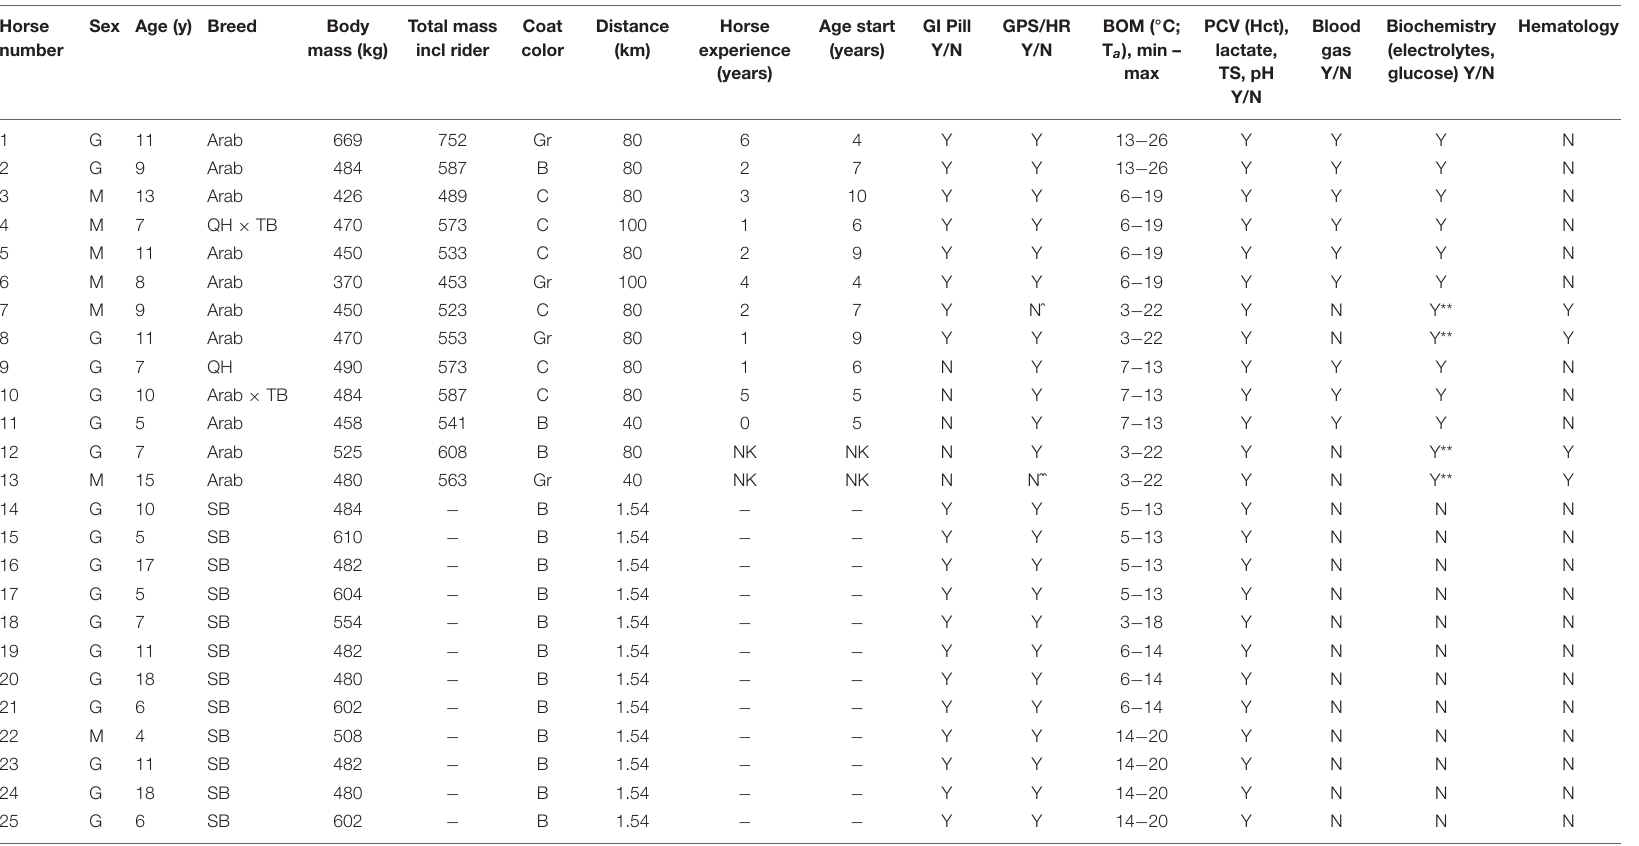
Horse 1–13: 13 endurance horses: G (n = 7), M (n = 6). Arab include part Arabian horses, QH, quarterhorse; TB, thoroughbred, endurance exercise; Horse 14–25 : 12 untrained trotters, all Standardbred (SB): G (n = 12), fast trot exercise; G, gelding; M, mare. Gr, gray; C, chestnut; B, bay; The riders’ and horses’ performance history includes: age start, indicates age (years) when horse started competing; horse experience, indicates number of years in competition (40 km or more); GI pill, gastrointestinal pill; GPS, global positioning system; HR, heartrate monitor (Polar); BOM (2020); Bureau of Meteorology, local stations closest to location of exercise at varying km distance from the actual event in total 4 endurance locations and 1 trotter racetrack, distance ranged from 5.3 to 53 km; BOM stations were: Roseworthy 27.9 km distance from ride at Sandy Creek; Rosedale station 5.3 km from ride at Tarlee; Meningie station 53 km from ride at Coorong; Nuriootpa station 28.8 km from ride at Sedan; Roseworthy station at 2.2 km from trotter racetrack; N, no; Y, yes; NK, not known; ∧ indicates HR only; ∧∧ indicates second 40 km only; blood gas analysis included pH, pCO 2 , pO 2 , HCO 3 − , base excess and lactate levels; **indicates biochemistry by VETSCAN (utilizes dry and liquid reagents); TS, total solids; TP, total protein; AST, Aspartate amino transferase; CK, creatinine